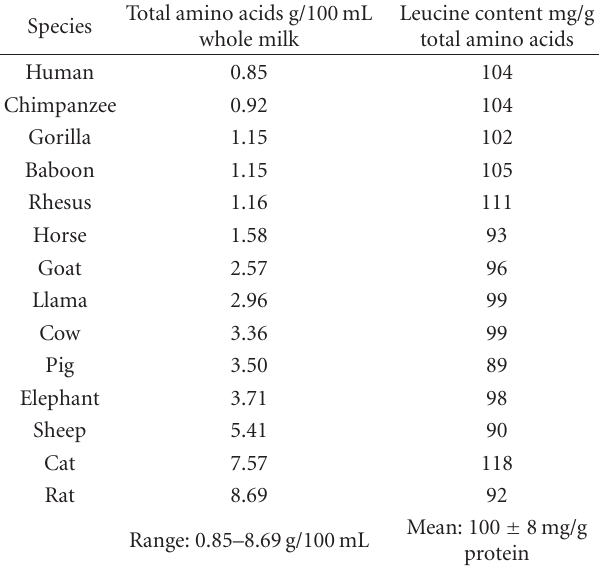
Table 2: Leucine content per g total milk protein in various species ∗